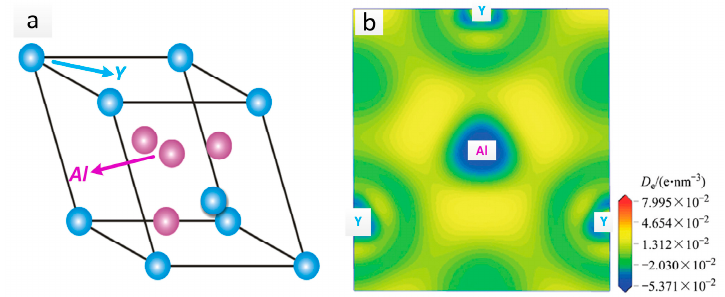
Figure 9. Al 2 Y crystal structure ( a ) and its electronic density difference (De) of the (111) plane ( b ). Table 1. Crystal structure parameters of Al 2 Y.